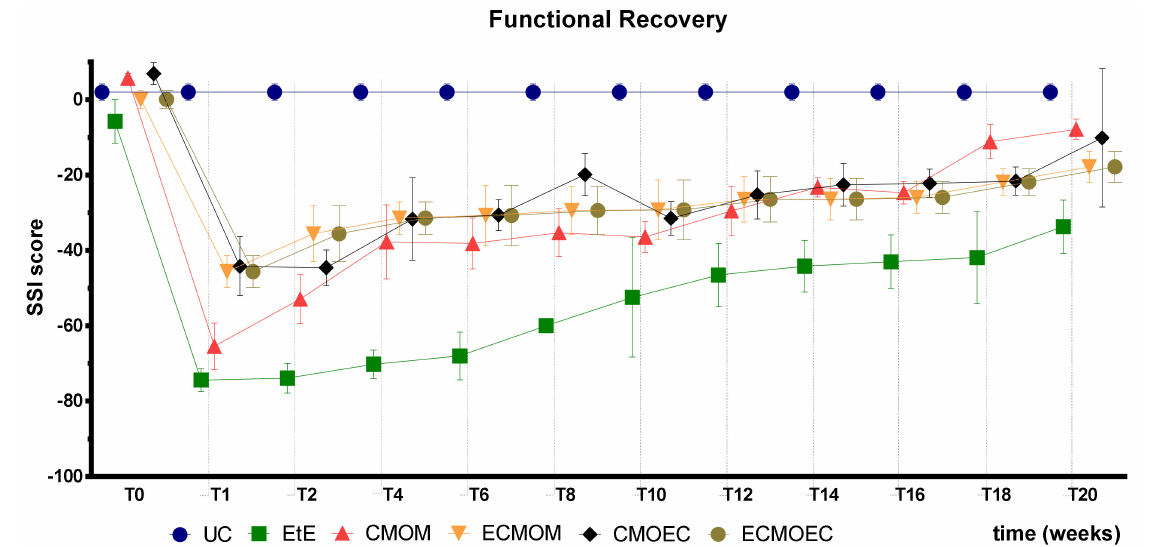
Figure 8. Functional assessment (SSI) over the 20-week recovery period (mean ± SEM). After the neurotmesis injury, a significant impairment of the hind limb was observed in all intervened groups. After week 1, a progressive improvement in SFI was observed in all therapeutic groups, and at the final timepoint, the CMOM group was the one with the best functional index